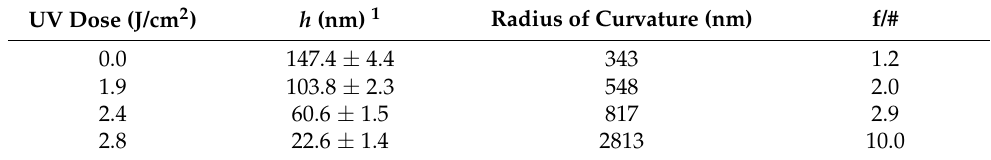
Table 1. Major structural and optical characteristics of the nanolenses with different UV doses. UV Dose (J/cm 2 )